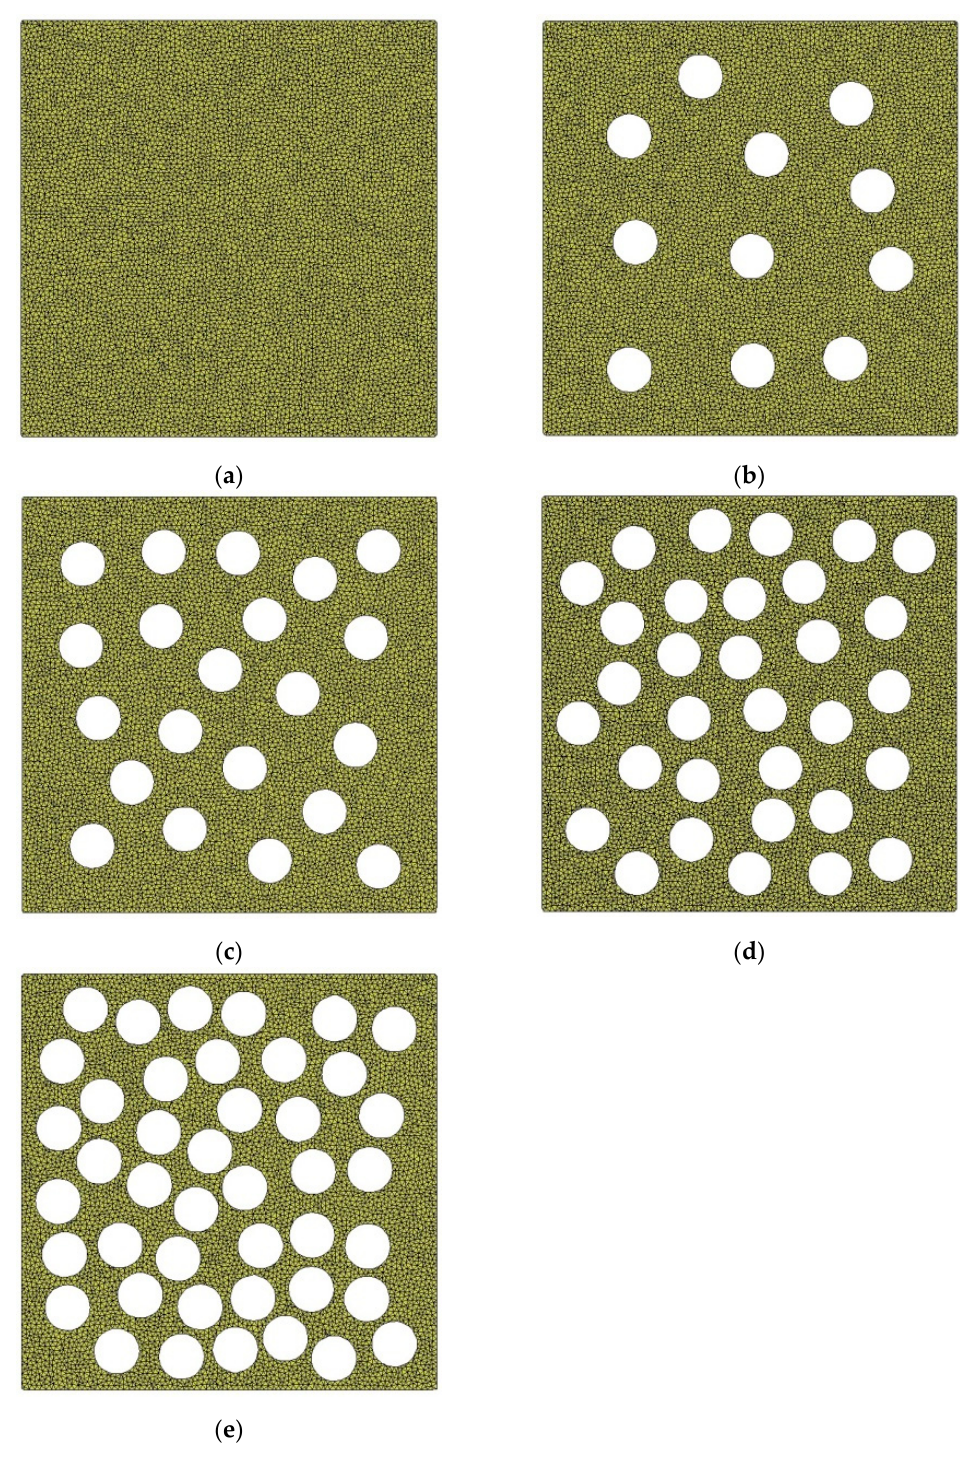
Figure 13. Models with different porosities: ( a ) n = 0; ( b ) n = 10.23%; ( c ) n = 19.27%; ( d ) n = 29.15%; ( e ) n = 40.67%.